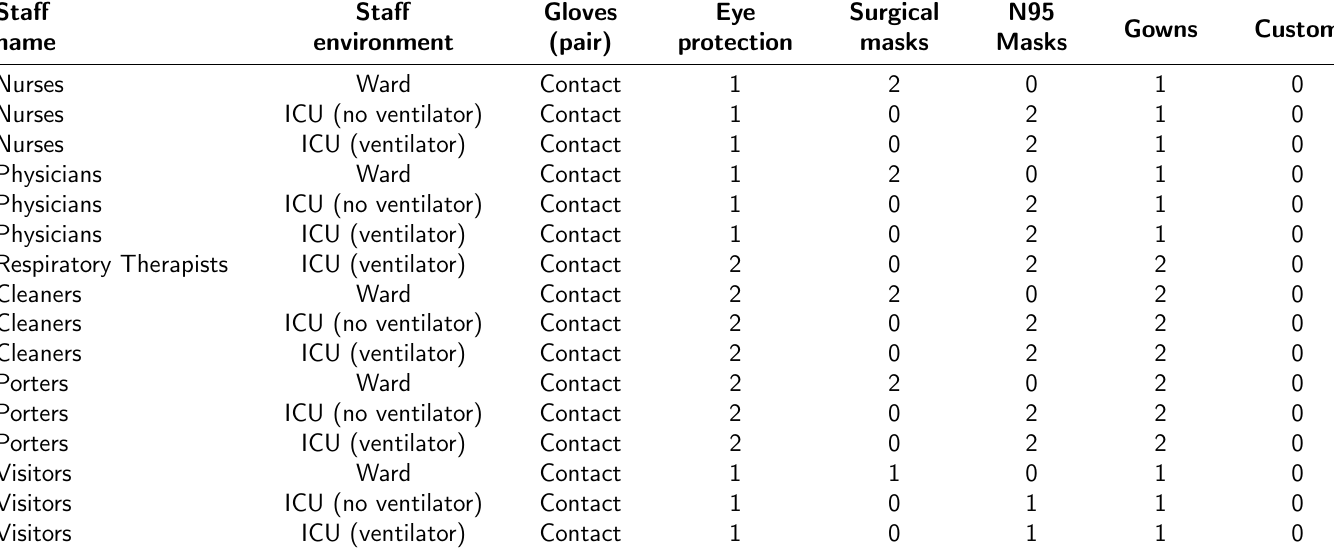
Table A2.6: Personal protective equipment (PPE) usage default parameter values (“Number of PPE per shift” or “Contact”)*